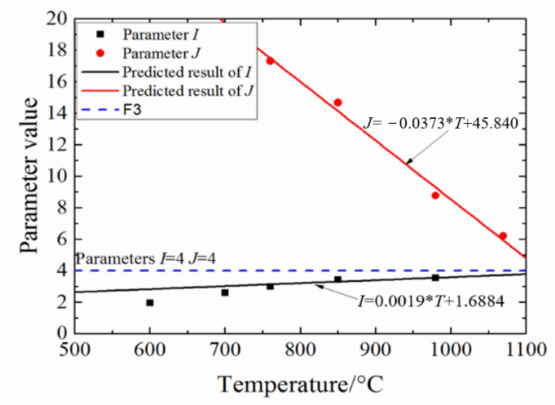
Figure 6. Parameters I , J fitting process. Table 9. DD6 material durability life prediction results. At different temperatures in different crystal orientations. Durability Temperature/ ◦ C